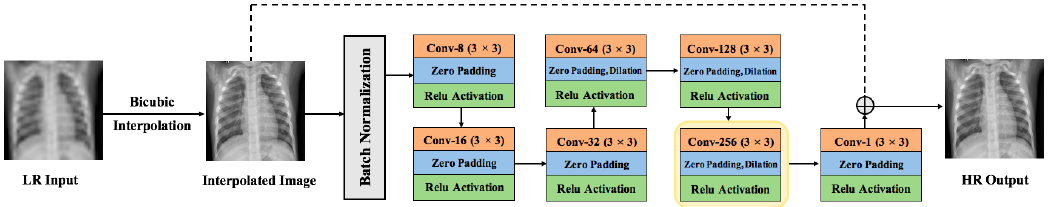
Figure 2. The structure of Hydra trunk (SISR model). To learn subsequent visual tasks, we truncated the SISR model at the deepest convolutional layer (yellow box) and appended task-specific heads as shown in Figure